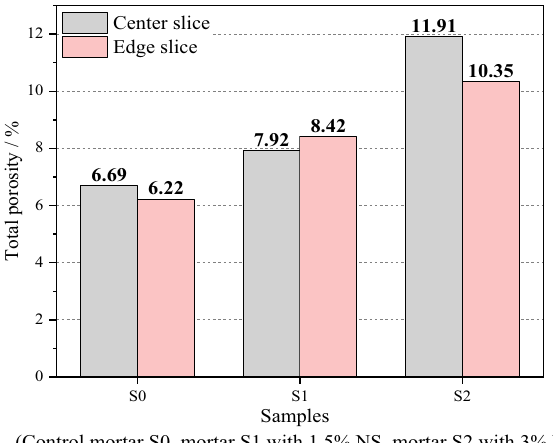
Figure 10: Total porosity of hardened mortar.